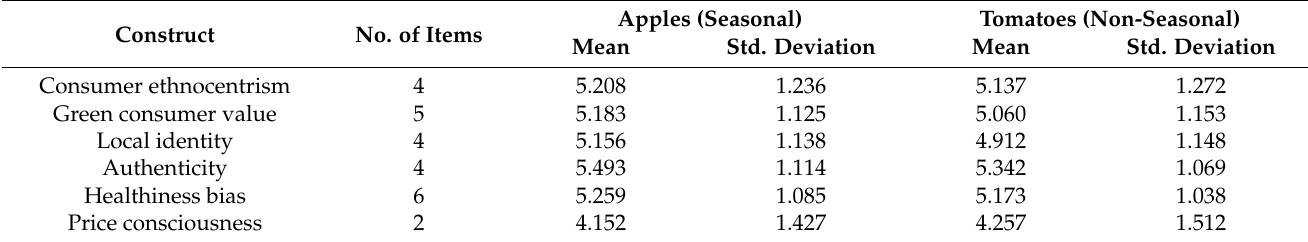
Table 4. Description of focal motive constructs.